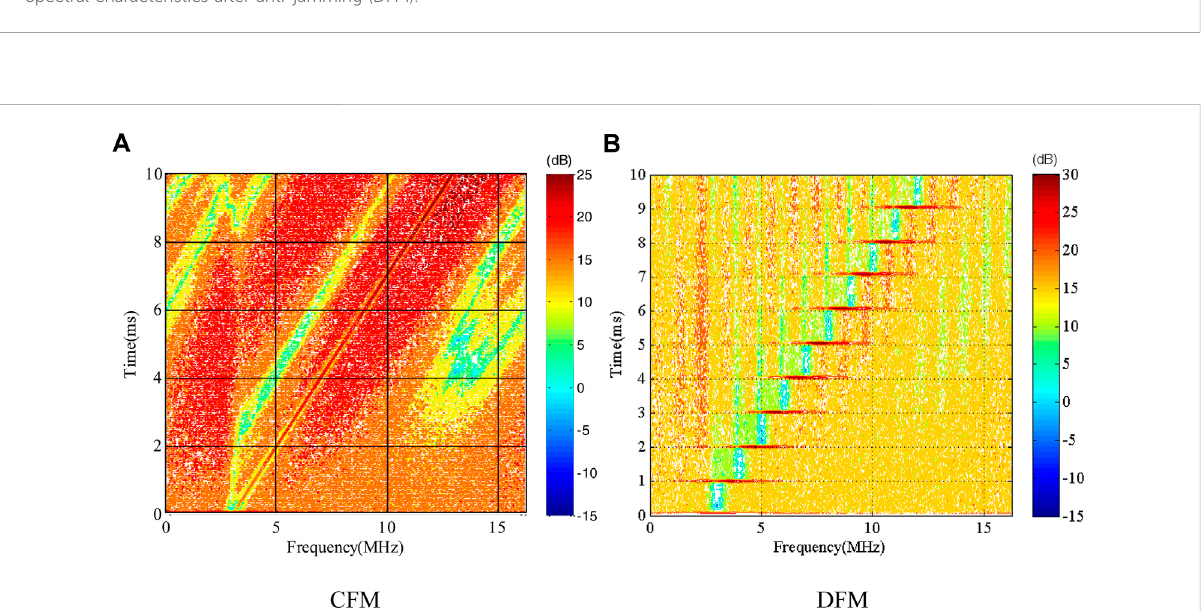
FIGURE 9 Spectral characteristics after anti-jamming